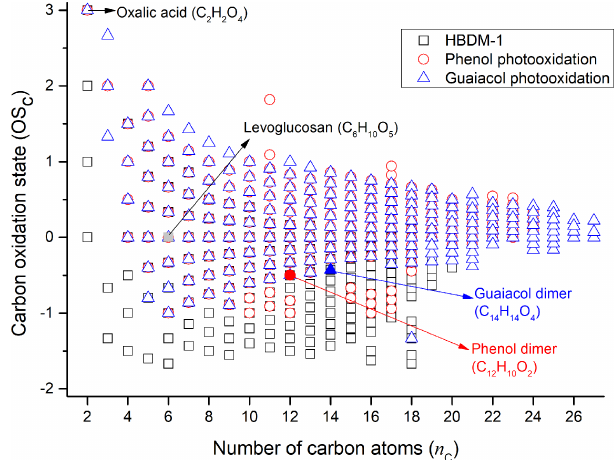
Figure 3. The distribution of carbon oxidation state (OS C ) for CHO molecules in HBDM-1 and laboratory samples produced from phenol and guaiacol photooxidation in the presence of H 2 O 2 (i.e. phenol + H 2 O 2 and guaiacol + H 2 O 2 ). The locations of ox- alic acid (identified in HBDM-1 and laboratory samples), levoglu- cosan (identified in HBDM-1), phenol dimer (identified in phe- nol + H 2 O 2 ), and guaiacol dimer (identified in guaiacol + H 2 O 2 ) are